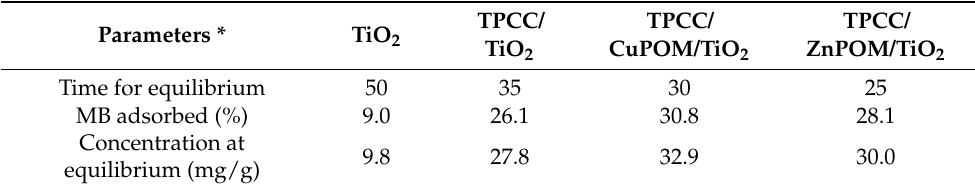
Table 4. Adsorption kinetic parameters using pseudo-first order, pseudo-second order and Elovich coefficient models.